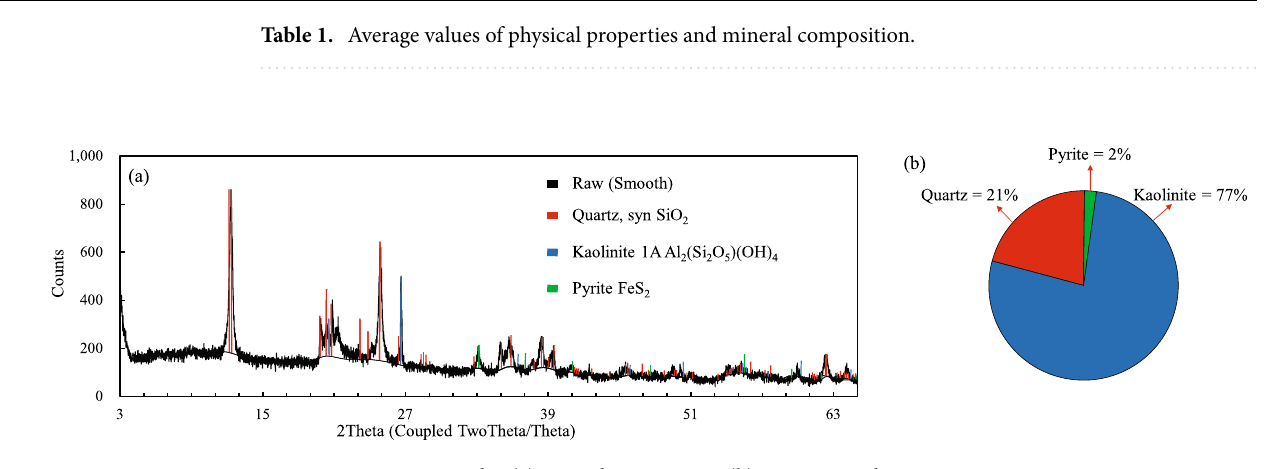
Figure 2. XRD test results. ( a ) XRD characteristics. ( b ) XRD mineral composition